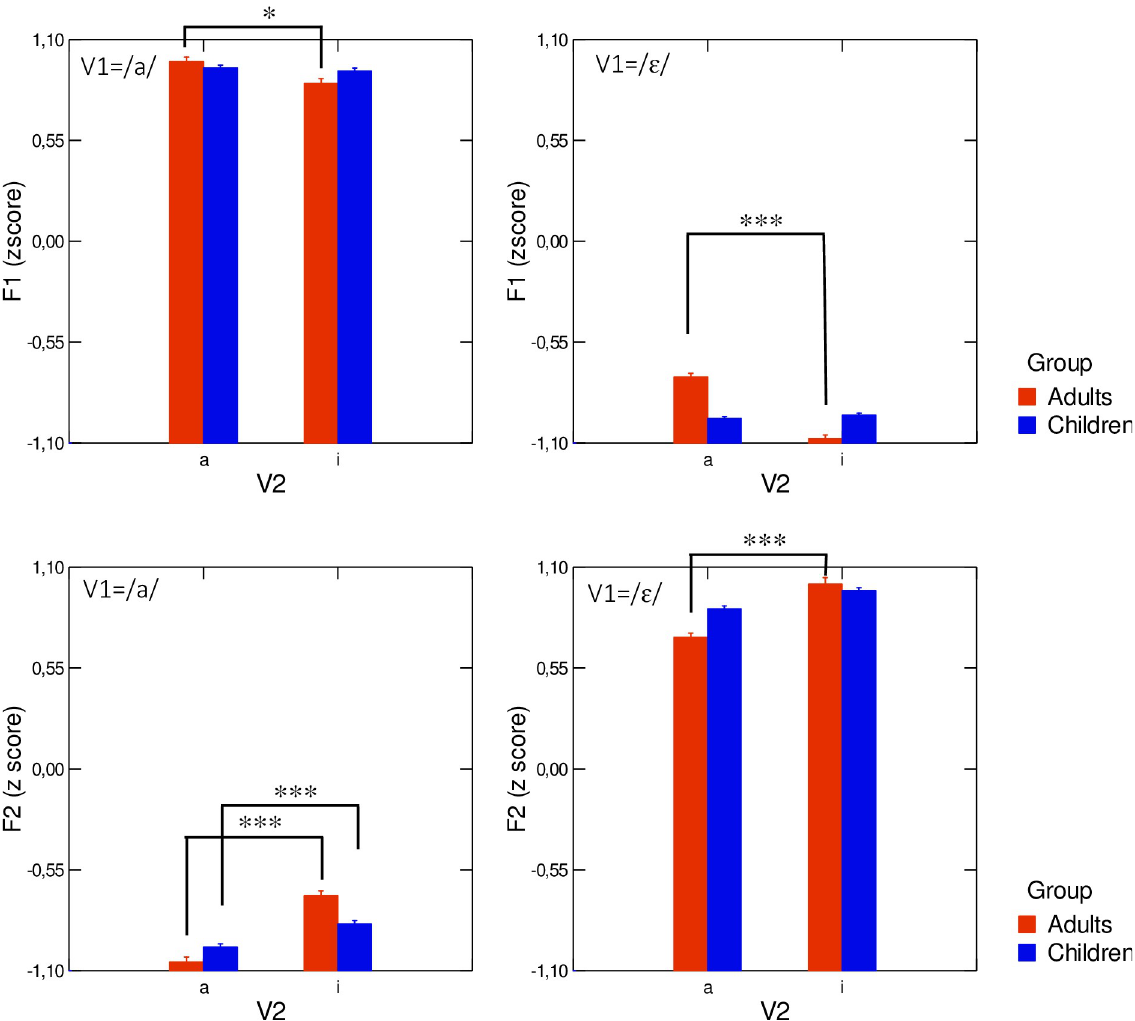
Fig 7. Average values of z-scored F1 and F2, for both speaker groups and V 2 contexts, in V 1 CV 2 sequences. Error bars are standard errors of the mean. formant values performed on V levels, within speaker groups and V levels are presented in 2 1 Table 1. For adults, significant anticipation was found in V F1 in V was significantly lower 1: 1 and F2 was significantly higher when V = /i/ than when V = /a/ (see top 4 rows in Table 1). 2 2 For children, no anticipation was found in V when considering F1. However, when consider- 1 ing F2, the results depended on V : if V = /a/ a significant anticipation was observed (7 th row 1 1 in Table 1) whereas for V = / ε /, there was a non-significant trend for anticipation. 1 Therefore, while anticipation was significant in adults both along the open/close (F1) and the antero-posterior (F2) directions, children did not show anticipation except for when V = 1 /a/ and formant F2 was considered. Interestingly, in this case changes in z-scored F2 associated with anticipation were clearly smaller in children (0.128) than in adults (0.370). Based on these findings, it was important to clarify whether the smaller magnitude of anticipation of V along 2 the F2 dimension observed in children was because all children anticipated V but to a lesser 2 extent than adults, or because some children anticipated V like adults while others did not. To 2